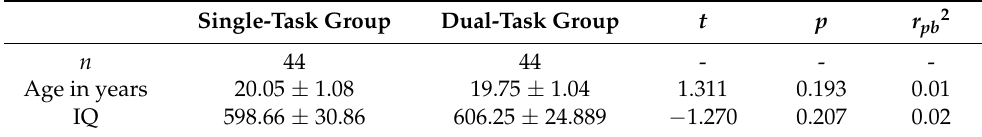
Table 1. Sample characteristics of the single-task group and dual-task group, mean ± standard deviation, Cohen’s effect size r pb 2 , t , and p -values are